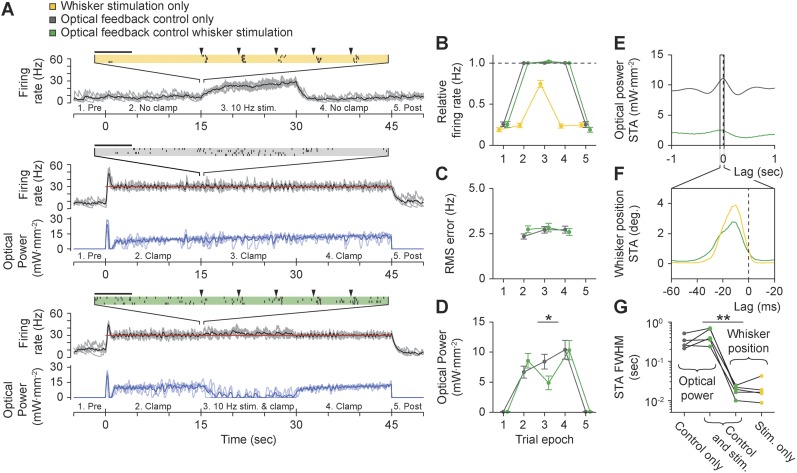
Using optogenetic feedback to control thalamic activity state during ongoing sensory input.(A) Real-time control of thalamic firing levels during external sensory drive. The firing rate of a single TCU cell (grey lines: single trials; black lines, average) is shown for three interleaved protocol types: 15-s trains of whisker stimuli (yellow), 45-s closed-loop control periods in the absence of whisker input (grey), and closed-loop control during concurrent whisker stimulation (green). (Top) 10 Hz whisker deflections occurred from 15–30 s within each trial (black triangles). Inset raster plot shows spikes times for 4 trials at the onset of whisker stimulation. (Middle) TCU firing was clamped at 30 Hz (red line) for the duration of each trial. Blue lines show the optical control signal (light blue: single trials; dark blue: average). (Bottom) TCU firing was clamped at 30 Hz (red line) for the duration of each trial and whisker stimuli were delivered from 15–30 s within each trial. Horizontal scale bars on the firing rasters indicate 100 ms. (B) mean relative (measured/target) firing rates, (C) mean RMS tracking errors, and (D) mean optical power across trials and units. Values are shown for each of the 5 trial epochs indicated on the abscissa axis of each time series in (A). Error bars indicate ± SEM. (E) Spike-triggered average (STA) optical power and (F) STA whisker position for the TCU shown in (A). Note the difference in time scales between (E) and (F). (G) FWHM of the STA for each TCU across trial types. Sample sizes: 5 TCUs, 3 to 5 applications of each protocol type per unit. *p = 0.024, **p = 0.0079; Mann–Whitney U Test.